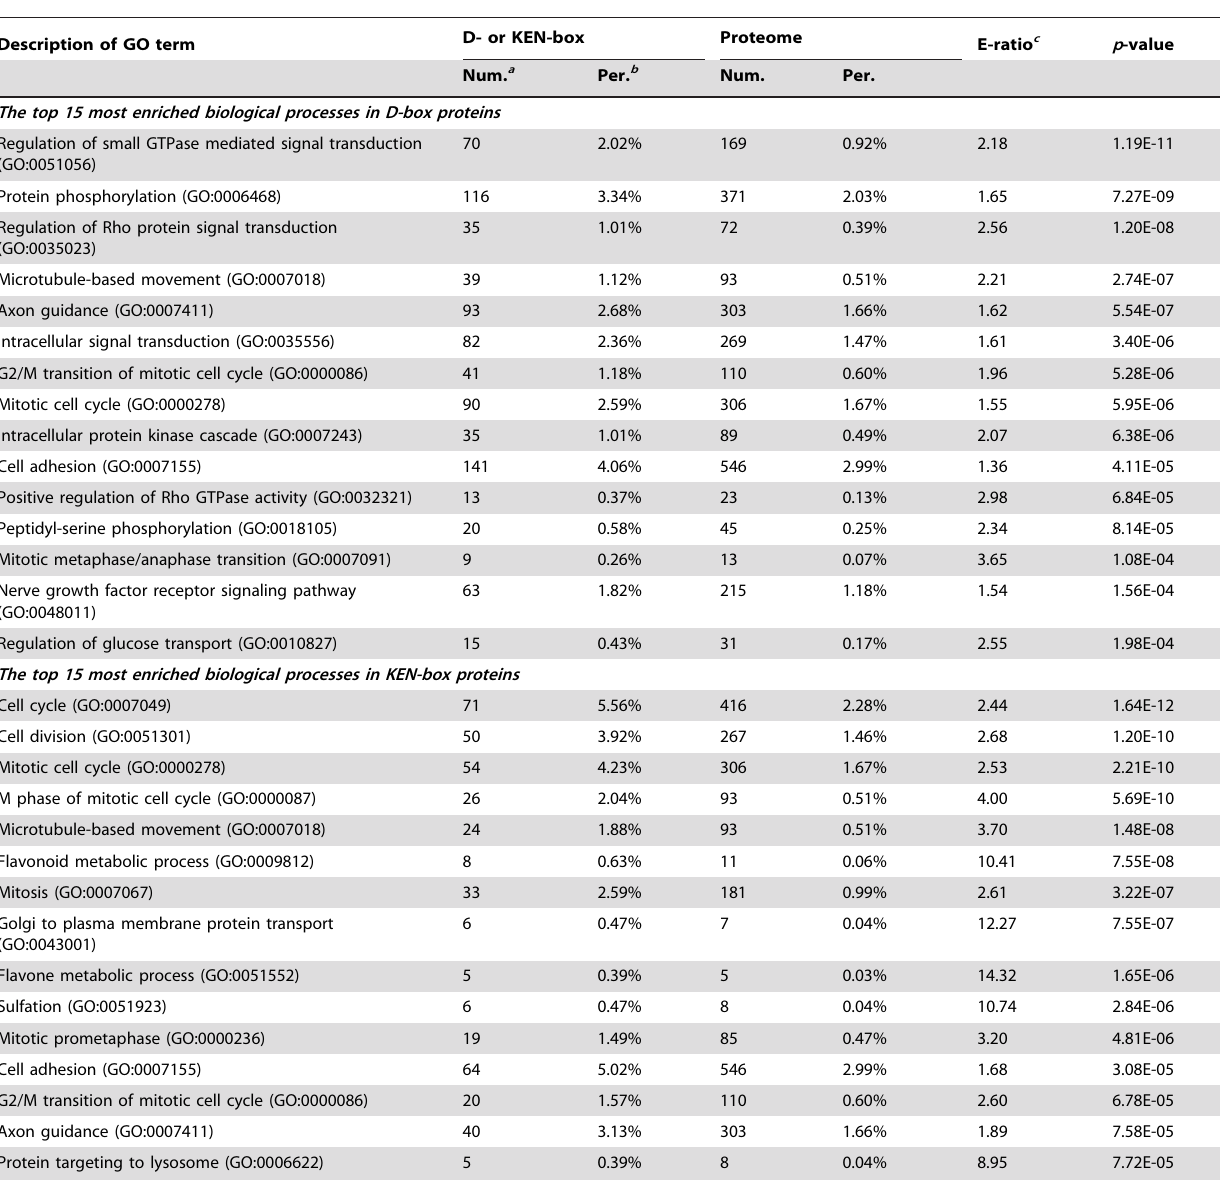
Table 3. Statistical analysis of the functional abundance and diversity of the D-box and the KEN-box proteins in H. sapiens .